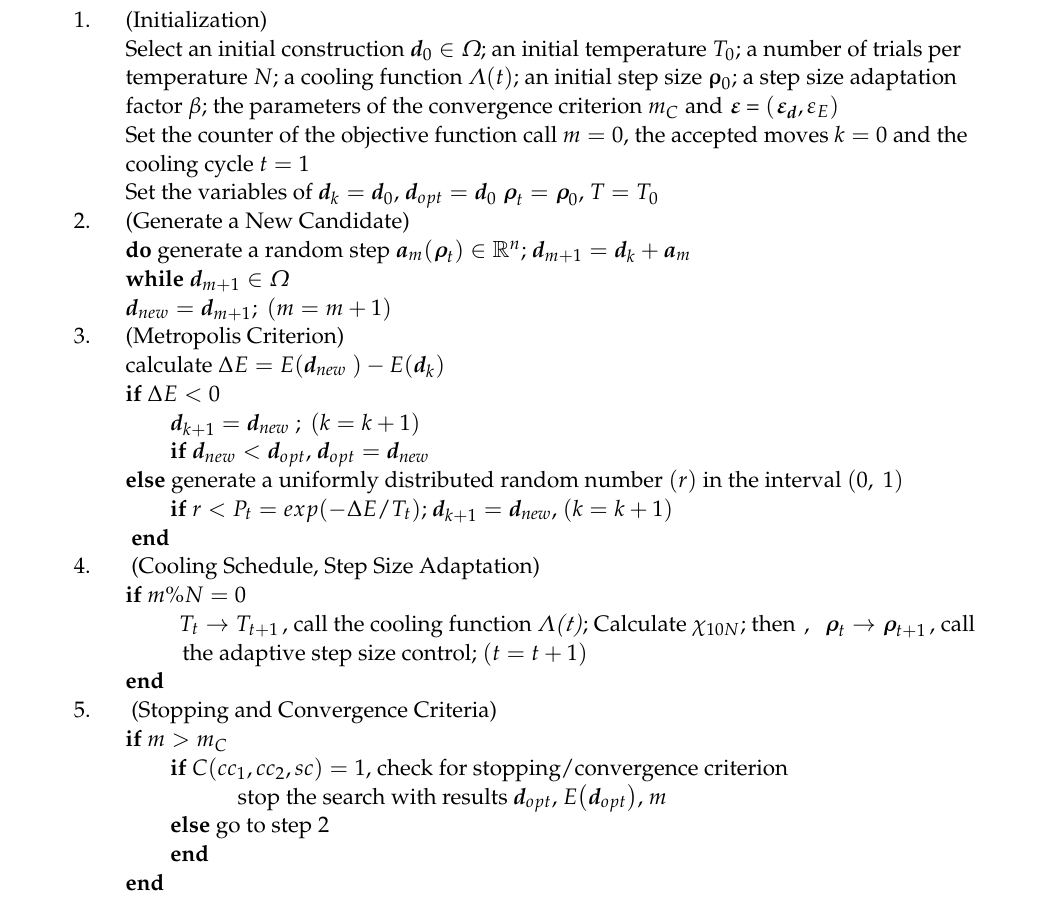
Algorithm 1: Simulated annealing algorithm with adaptive step size